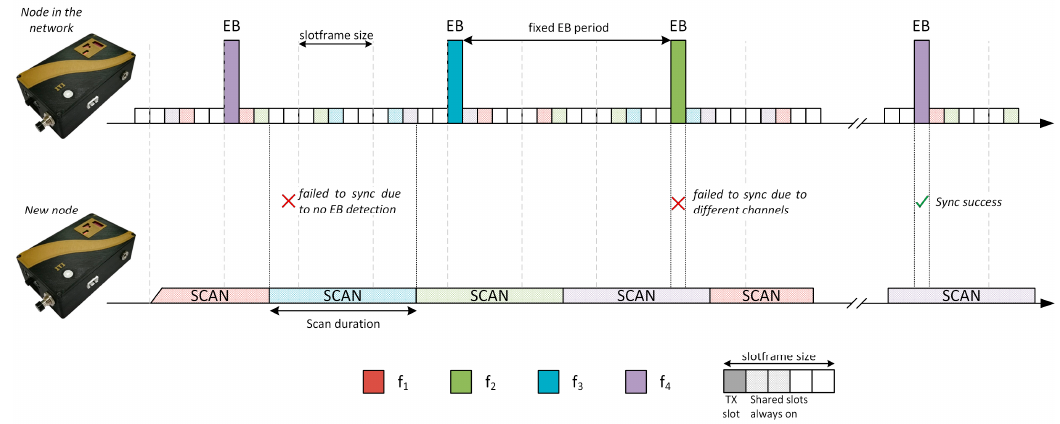
Figure 1. Enhanced Beacon (EB) scan process in Time Slotted Channel Hopping (TSCH) [6].